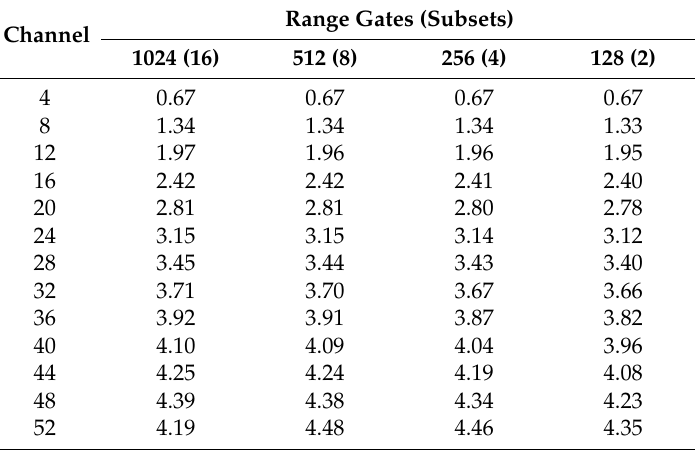
Table 2. DSP core performance measured in GFLOPS after mitigating cache